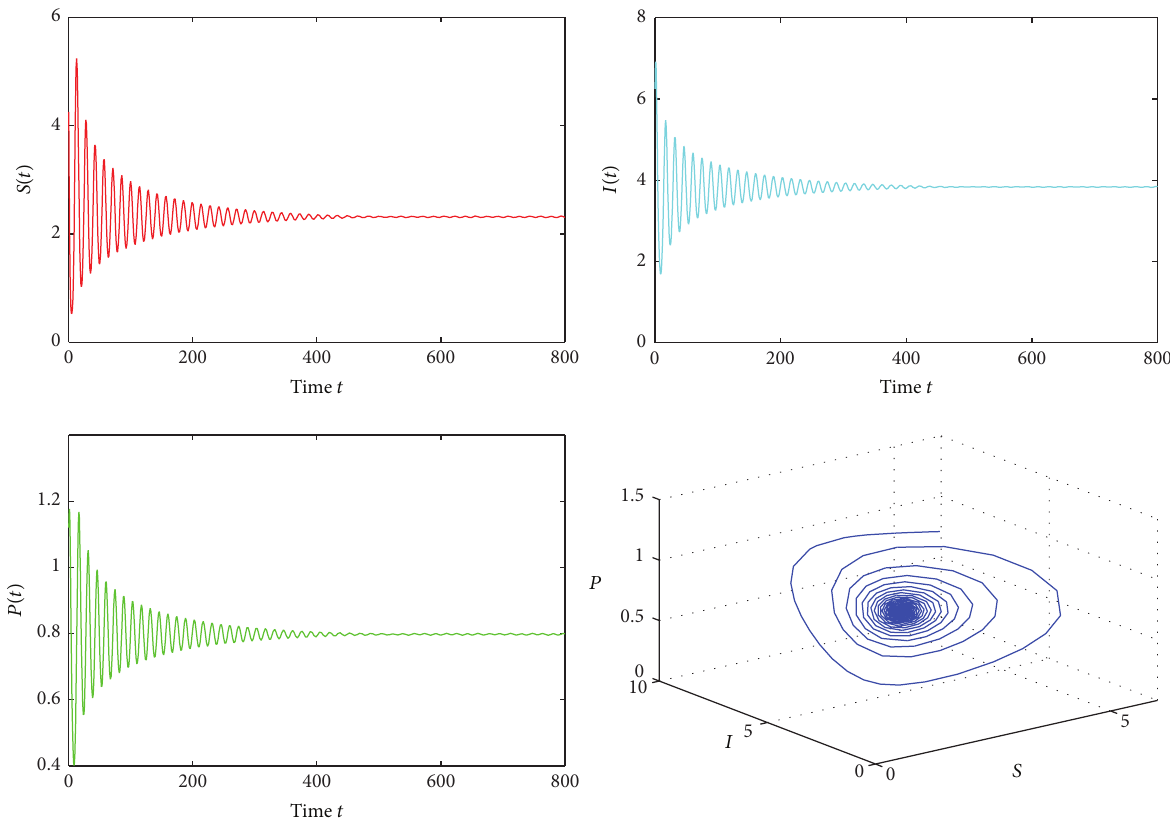
Figure 7: 𝐸 ∗ is asymptotically stable when 𝜏 2 = 0.75 < 1.0782 = 𝜏 ∗ 20 and 𝜏 1 = 0.15 ∈ (0, 𝜏 10 )